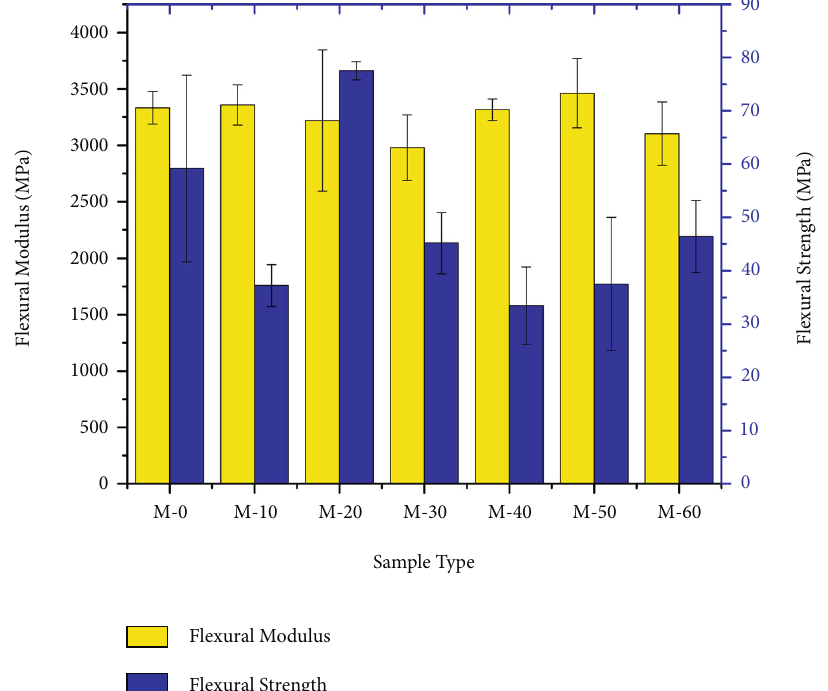
Figure 14: A representative graph for fl exural strength and fl exural modulus for mango seed shell/epoxy